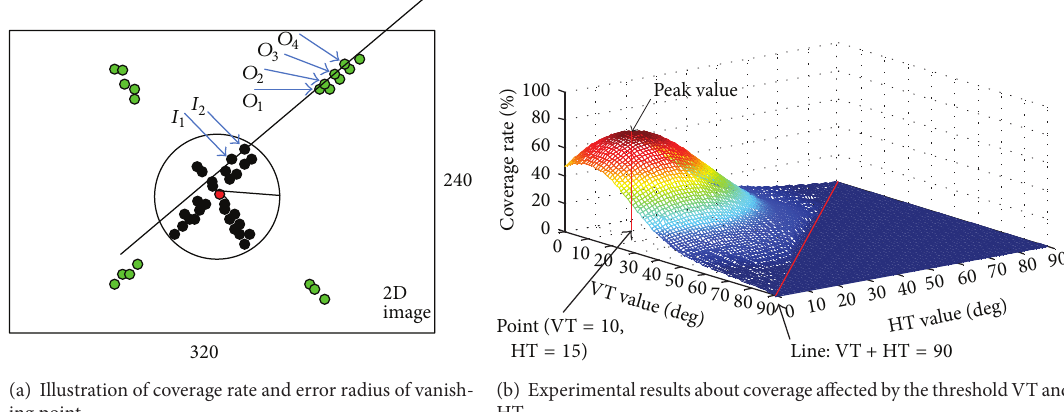
Figure 6: Error radius of vanishing point and coverage rate affected by the threshold VT and HT.